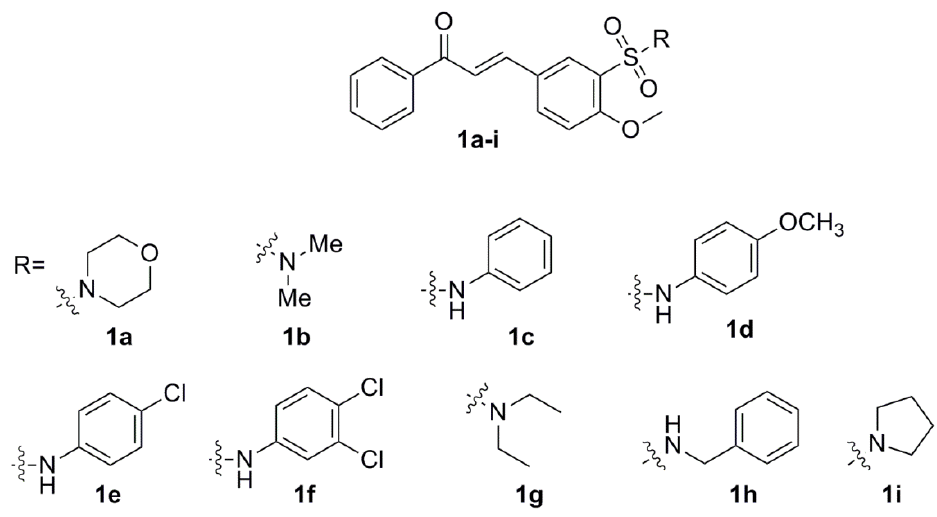
Figure 1. 4-Methoxychalcone derivatives 1a – i synthesized [17].